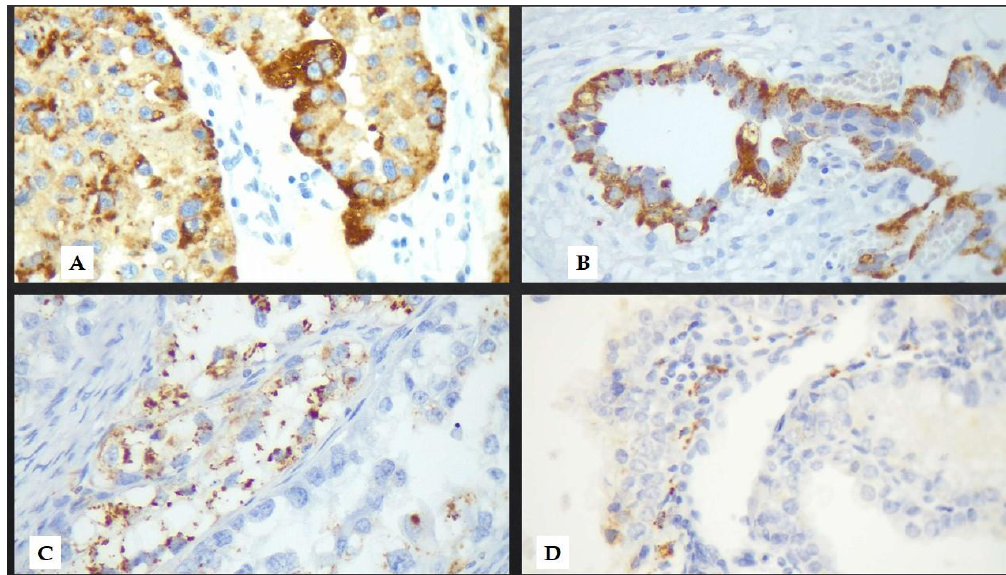
Fig. 1. (A and B) IHC stained slides (400x) showing strongly positive coarse (1+) cytoplasmic granules (3+), (C) moderate coarse and fine cytoplasmic granules (2+) and (D) fine cytoplasmic